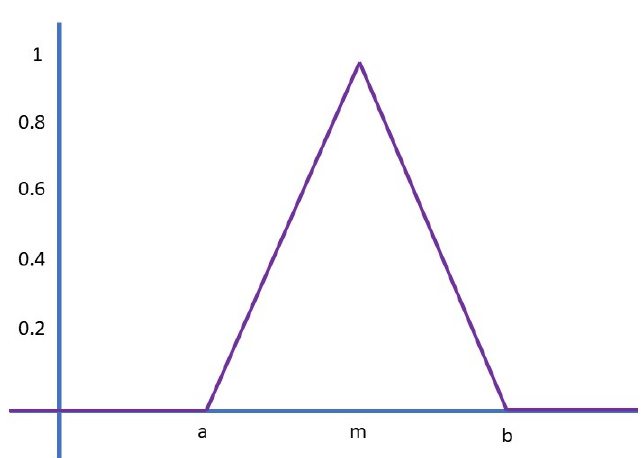
Figure 11. Tri MF Plot Points.